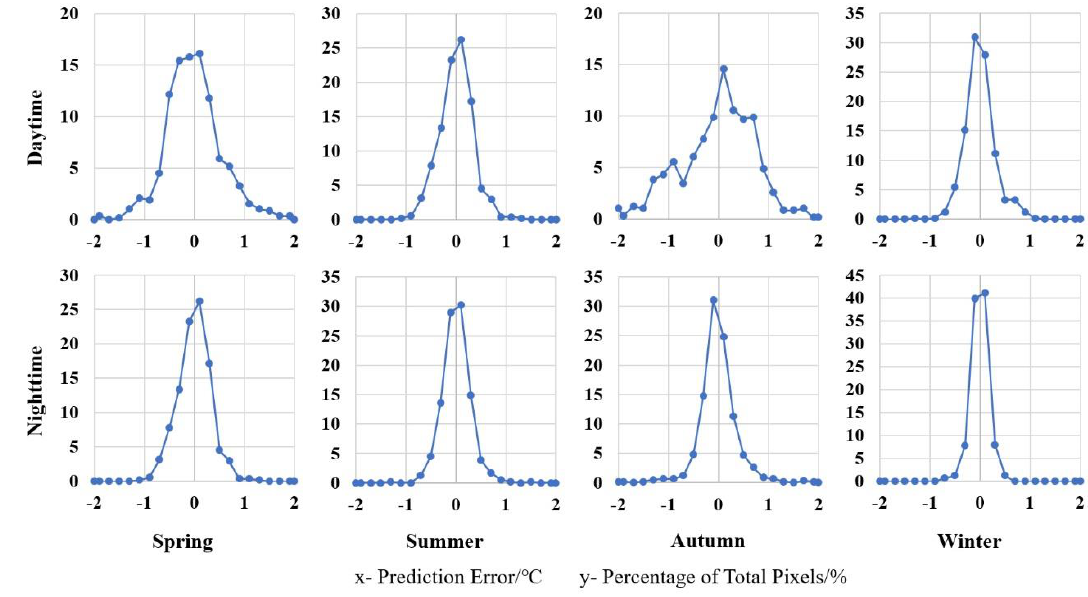
Figure 11. Error histogram of RF models. ( x -axis represents the prediction error/°C; y -axis represents percentage of total pixels of study area/%).